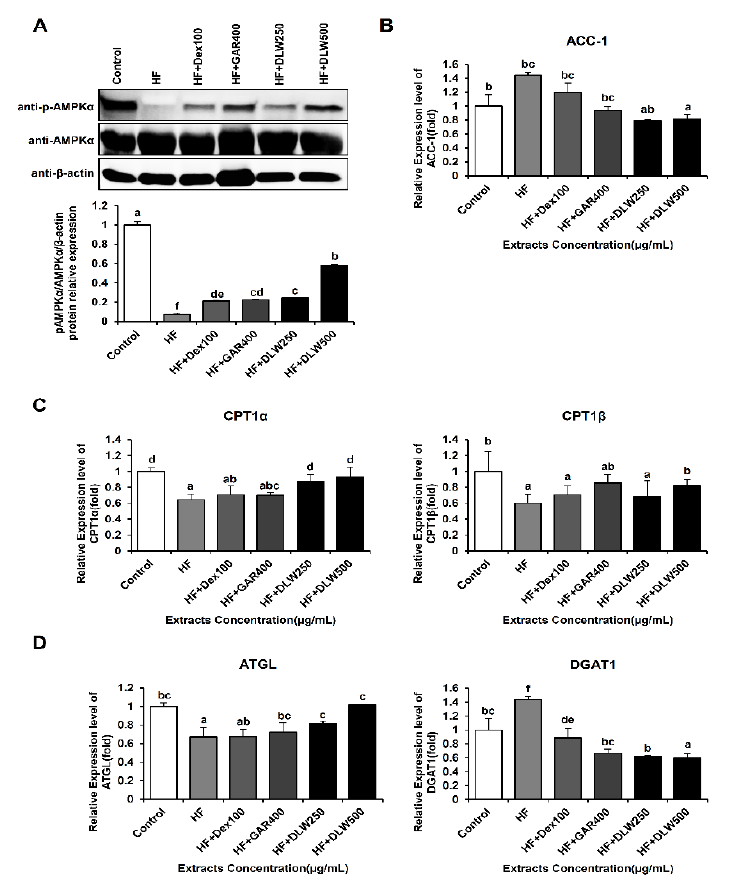
Figure 4. Effect of D. morbifera water (DLW) extract on gene expression levels related to lipid synthesis, lipid degradation, fatty acid oxidation, and transcription factors in the white adipose tissue (WAT) of HFD-induced obese mice. DLW influenced protein and mRNA expression of adipogenic genes in mouse WAT. ( A ) After 12 weeks of DLW treatment, the protein expression levels of p-AMPK by Western blot analysis were evaluated in WAT from mice fed standard diet, HFD, and HFD with DLW. Densitometric analyses for p-AMPK are presented as the relative ratio of each protein to total AMPK α , respectively. The mRNA expression levels of ( B ) ACC-1 and ( C ) CPT1 α and CPT1 β and ( D ) ATGL and DGAT1 by qRT-PCR were evaluated in WAT from mice fed standard diet, HFD, and HFD with DLW. Con, control group fed standard diet; HF, group fed high-fat diet; HF + Dex100, group fed high-fat diet in conjunction with Dextrin 100 mg/kg; HF + GAR400, group fed high-fat diet in conjunction with Garcinia 400 mg/kg; HF + DLW250, group fed high-fat diet in conjunction with D. morbifera water (DLW) extract 250 mg/kg; HF + DLW500, group fed high-fat diet in conjunction with D. morbifera water (DLW) extract 500 mg/kg; p-AMPK , phospho-AMP-activated protein kinase; AMPK , AMP-activated protein kinase; ACC , acetyl-CoA carboxylase; CPT1 α , carnitine palmitoyltransferase-1 alpha; CPT1 β , carnitine palmitoyltransferase-1 beta; ATGL, Adipose triglyceride lipase; DGAT1, Diacylglycerol acyltransferase 1. The values presented are the means ± SD of three independent experiments. Means with different superscript letters are significantly different, p < 0.05. (one-way analysis of variance ANOVA followed by Tukey’s multiple test).